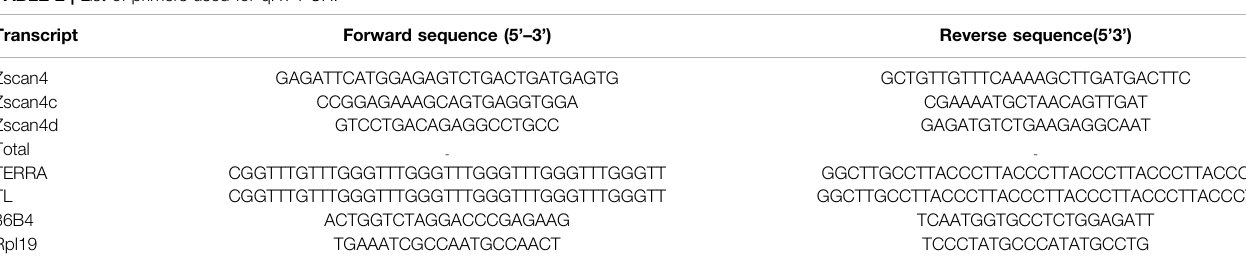
TABLE 2 | List of primers used for